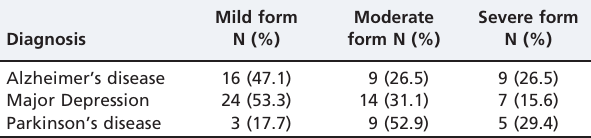
Table 2 - Disease severity according to diagnosis.